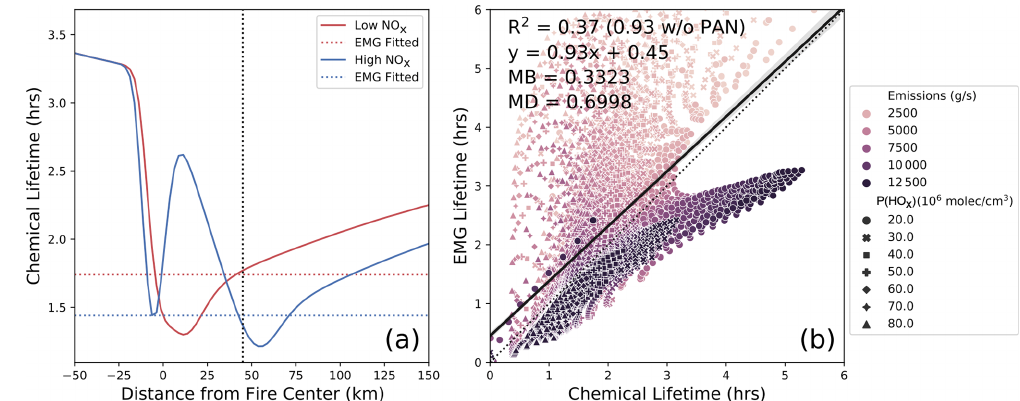
Figure 8. (a) Illustration of the variation of NO x chemical lifetime with distance from fire center at both low (red) and high NO x emissions (blue). The EMG-fitted effective lifetime is shown as horizontal dashed lines. The vertical line indicates the distance where chemical lifetime and EMG-fitted lifetime agree. (b) Scatter plot between EMG-fitted versus overall chemical NO x lifetimes downwind calculated using varying NO x emissions, P (HO x ) , and VOC reactivities, where the colors represent different emission levels, and the symbols represent different levels of P (HO x ) . The chemical lifetime is calculated as the mean NO x concentration divided by the mean chemical loss of NO x through the formation of HNO 3 and RONO 2 over downwind region. We define the regional mean as the region between fire center and the downwind area where NO x concentration is higher than background, where background value is estimated from the EMG function ( B in Eq.